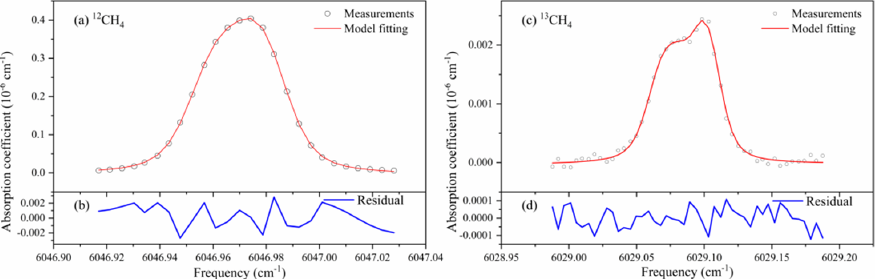
Figure 11. Spectral measurements of ( a ) 12 CH 4 and ( c ) 13 CH 4 isotope in ambient air, together with model fittings. ( b ) and ( d ) are fitting residuals.